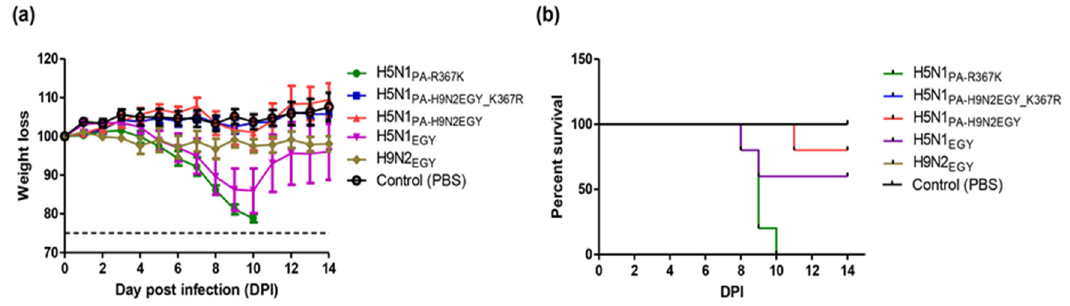
Figure 9. Pathogenicity of wild-type H5N1 EGY, H9N2 EGY , reassortants H5N1 PB2-H9N2EGY and H5N1 PA-H9N2EGY , mutants H5N1 PA_R367K and H5N1 PA-H9N2EGY_K367R in female BALB / c mice. Mice were infected with 10 3 PFU of each virus in 30 µ L PBS. ( a ) The body-weight reduction rate and the mortality rate as demonstrated by weight loss ( a ) and the survival rate ( b ), respectively, were monitored for 14 dpi. Mice judged moribund (body weight loss > 25%) were euthanized.